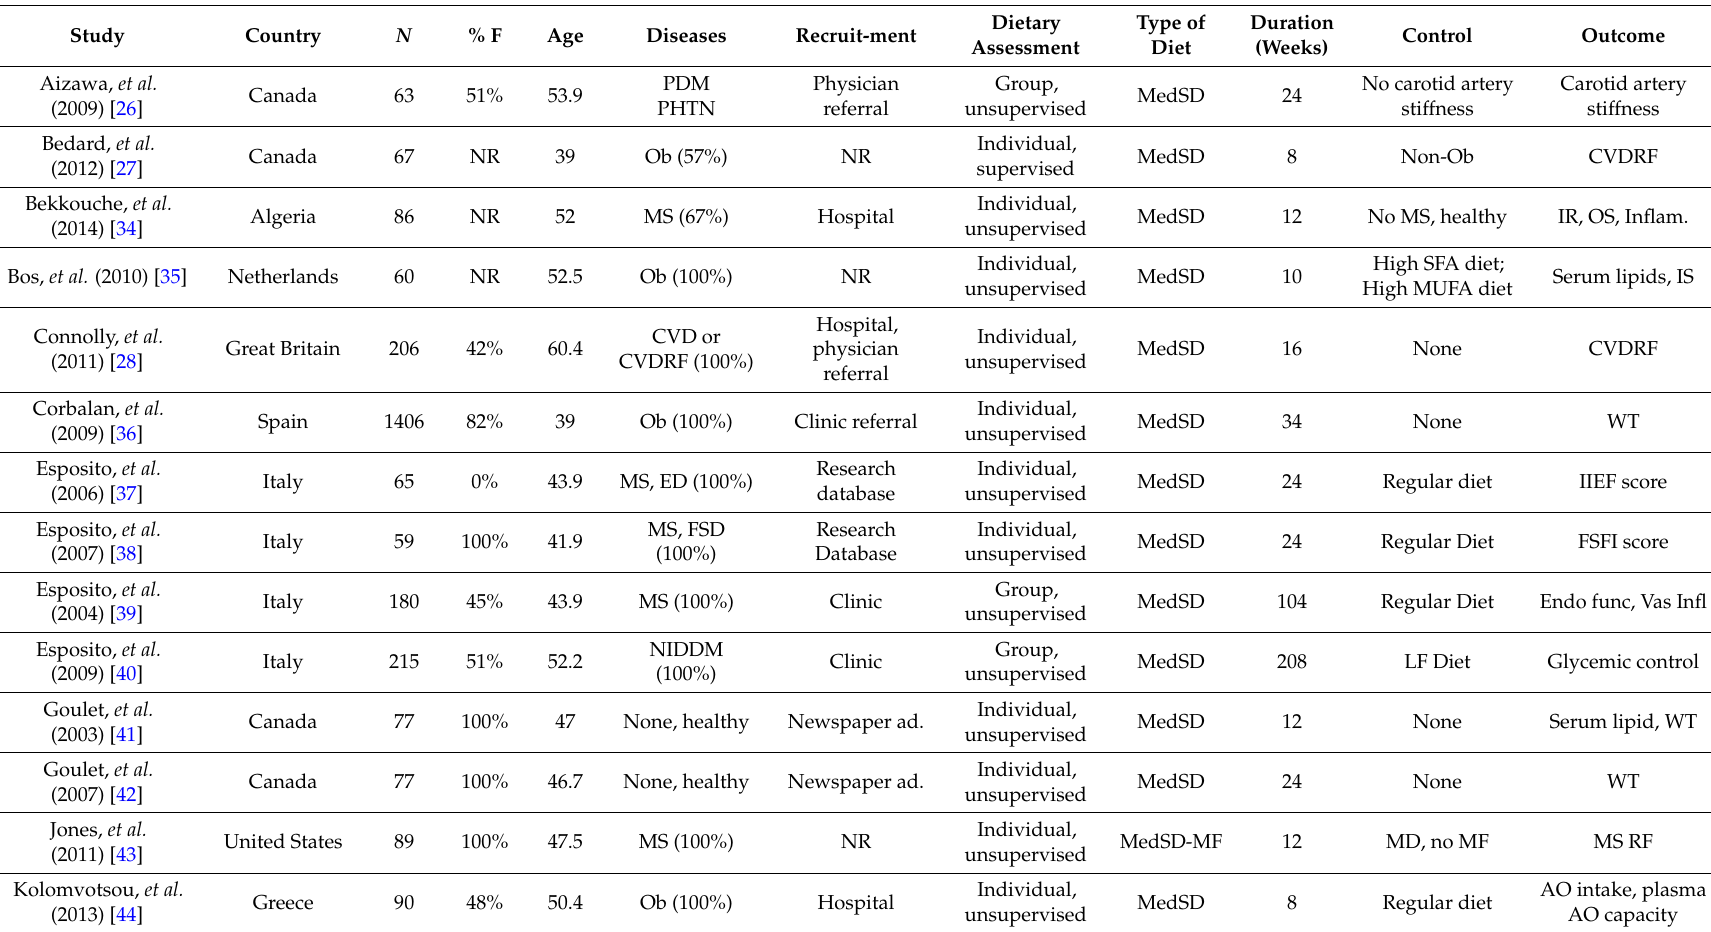
Table 1. Description of Included